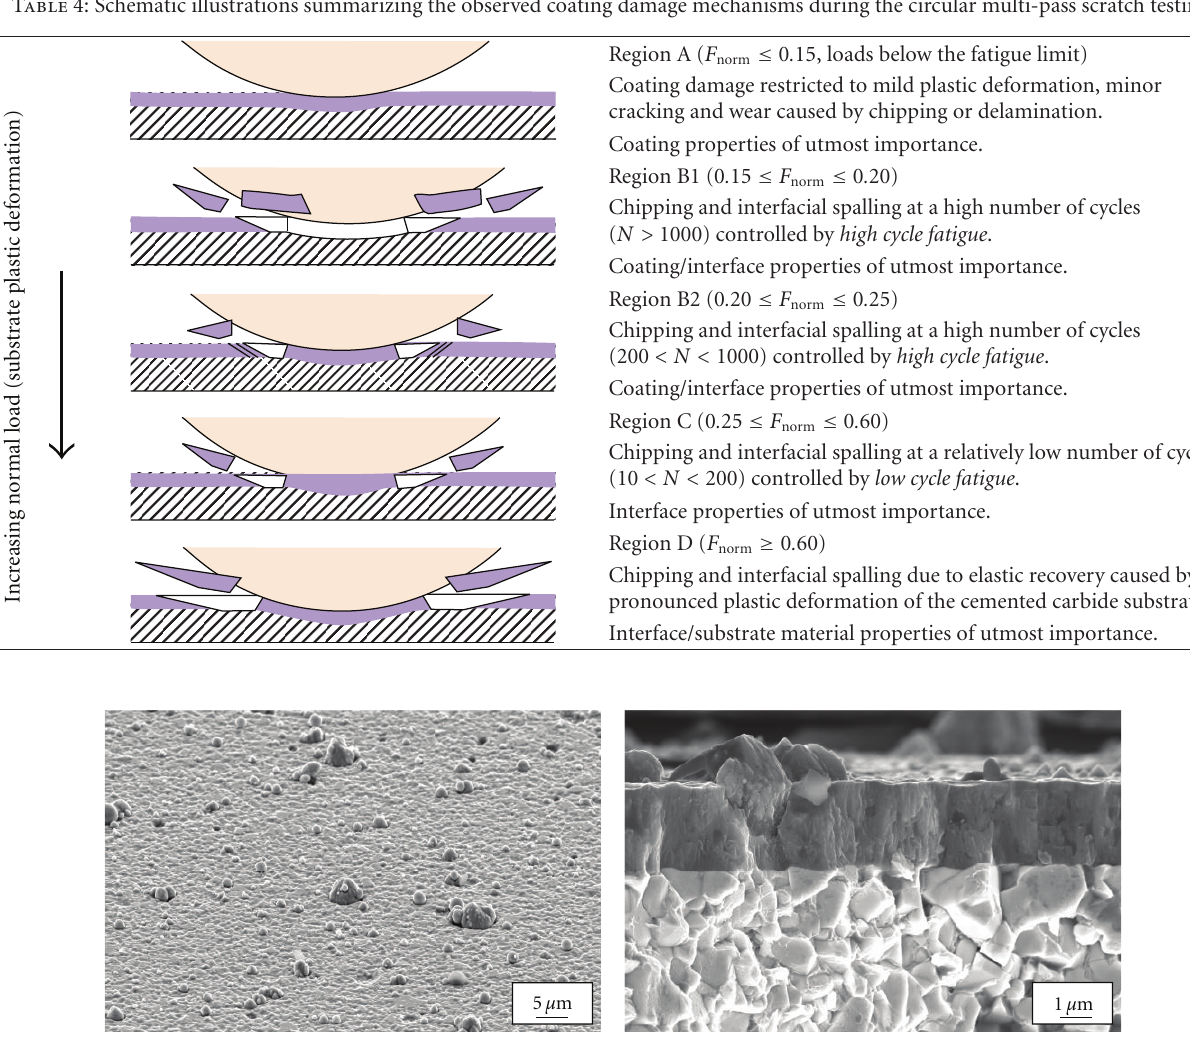
(Al 0 . 7 Cr 0 . 3 ) 2 O 3 , representing state of the art PVD coatings for metal cutting applications were included in the